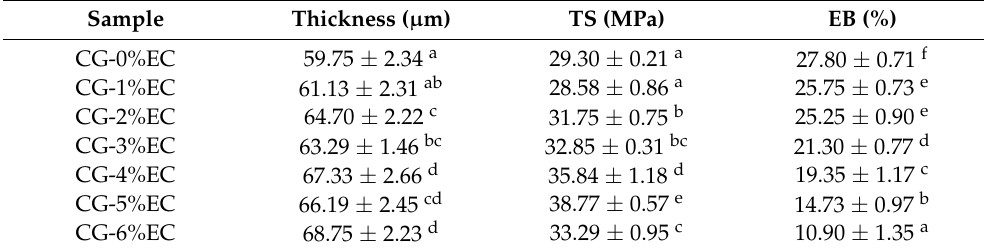
Table 1. Thickness, TS, and EB of films incorporated with different amounts of EC.